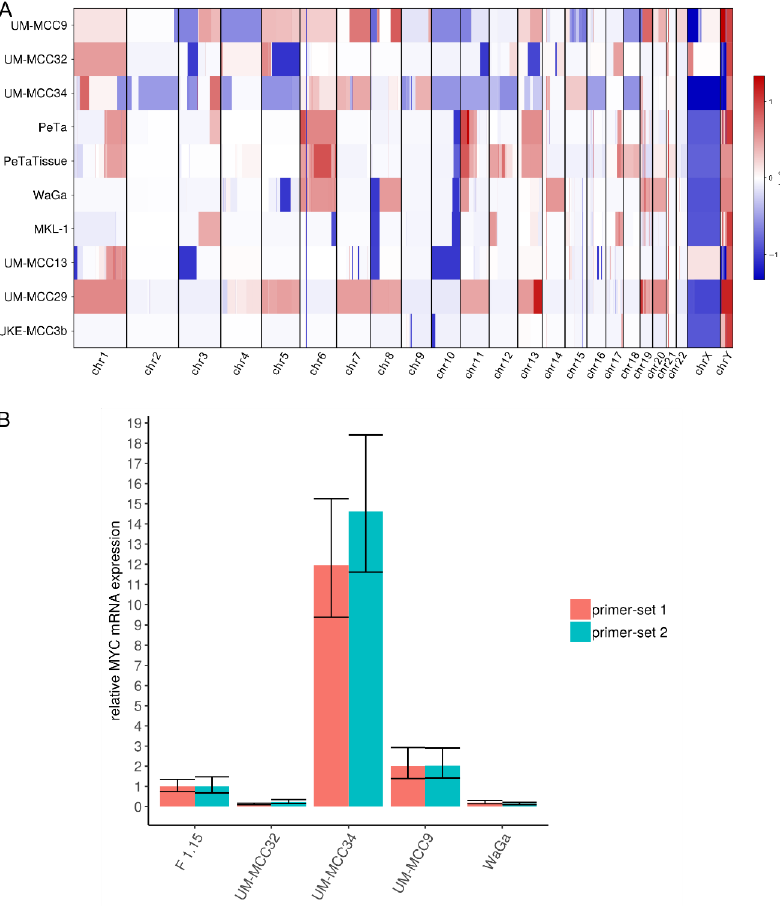
Figure 4. CNVs in MCC cell lines. ( A ) Graphical display of derived CNVs using CNVkit with sex chromosomes relative to haploid reference; ( B ) Expression of MYC mRNA in MCC cell lines was determined by qRT-PCR. Cq values were normalized to GAPDH expression and compared to ΔCq value of fibroblasts (F 1.15).